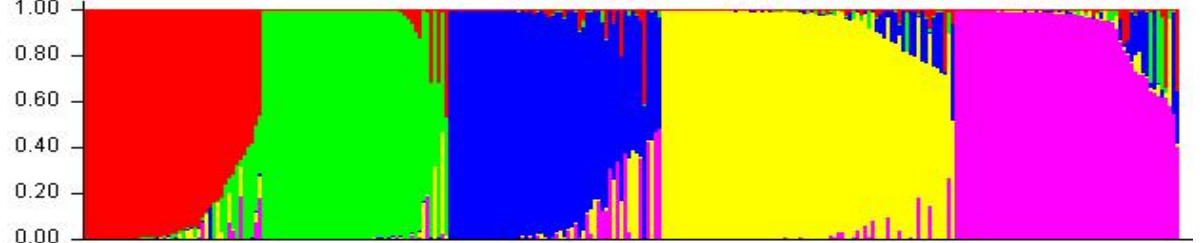
Figure 3. Population structure of 288 maize inbred lines revealed by 89 polymorphic SSRs markers at K = 5. Each inbred line is represented by a vertical line which indicates the membership coefficients for each individual. The five groups are shown in different colors: G1 (Green), G2 (Red), G3 (Purple), G4 (Yellow), and G5 (Blue). See Table S1 for details on group membership.